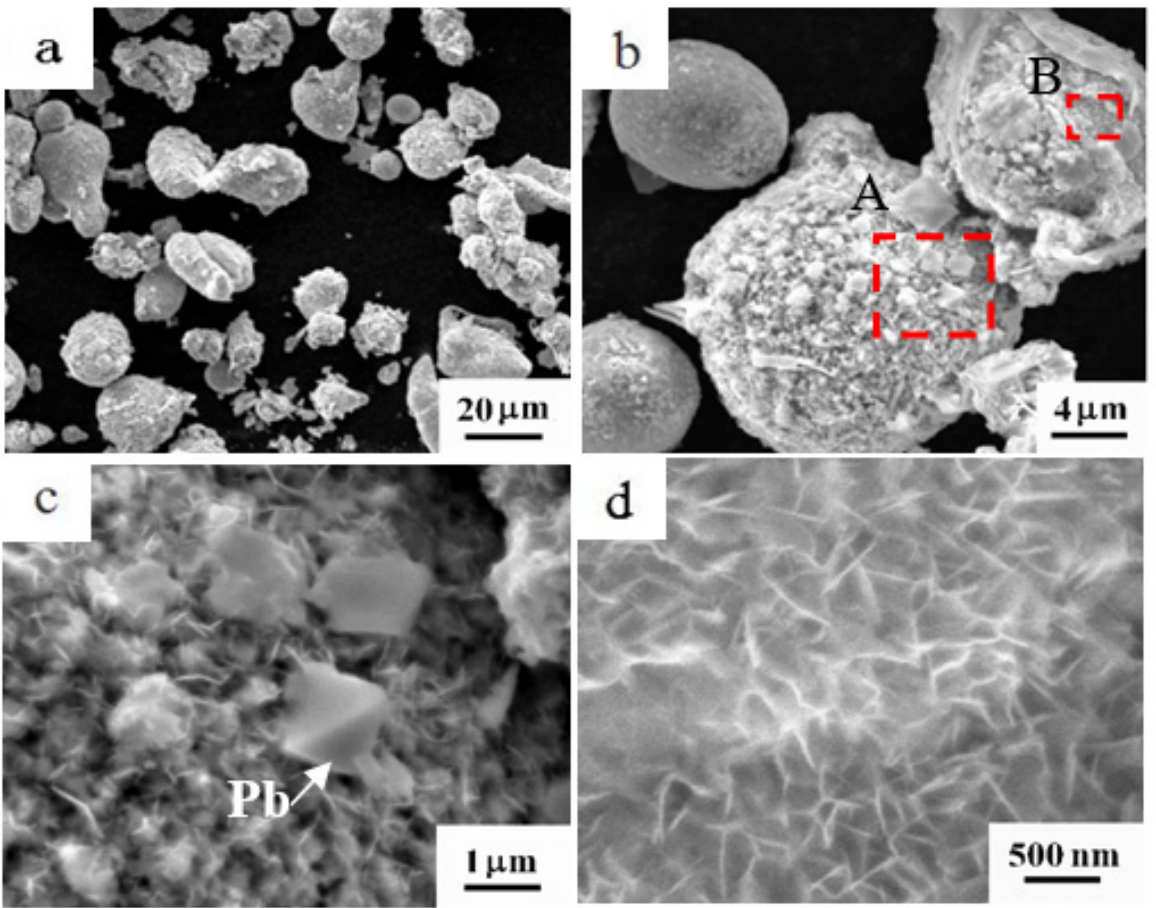
Figure 13. ( a , b ) SEM images with different magnifications of the reacted FeSiB AP and ( c , d ) enlarged views of the corresponding regions A and B, respectively.